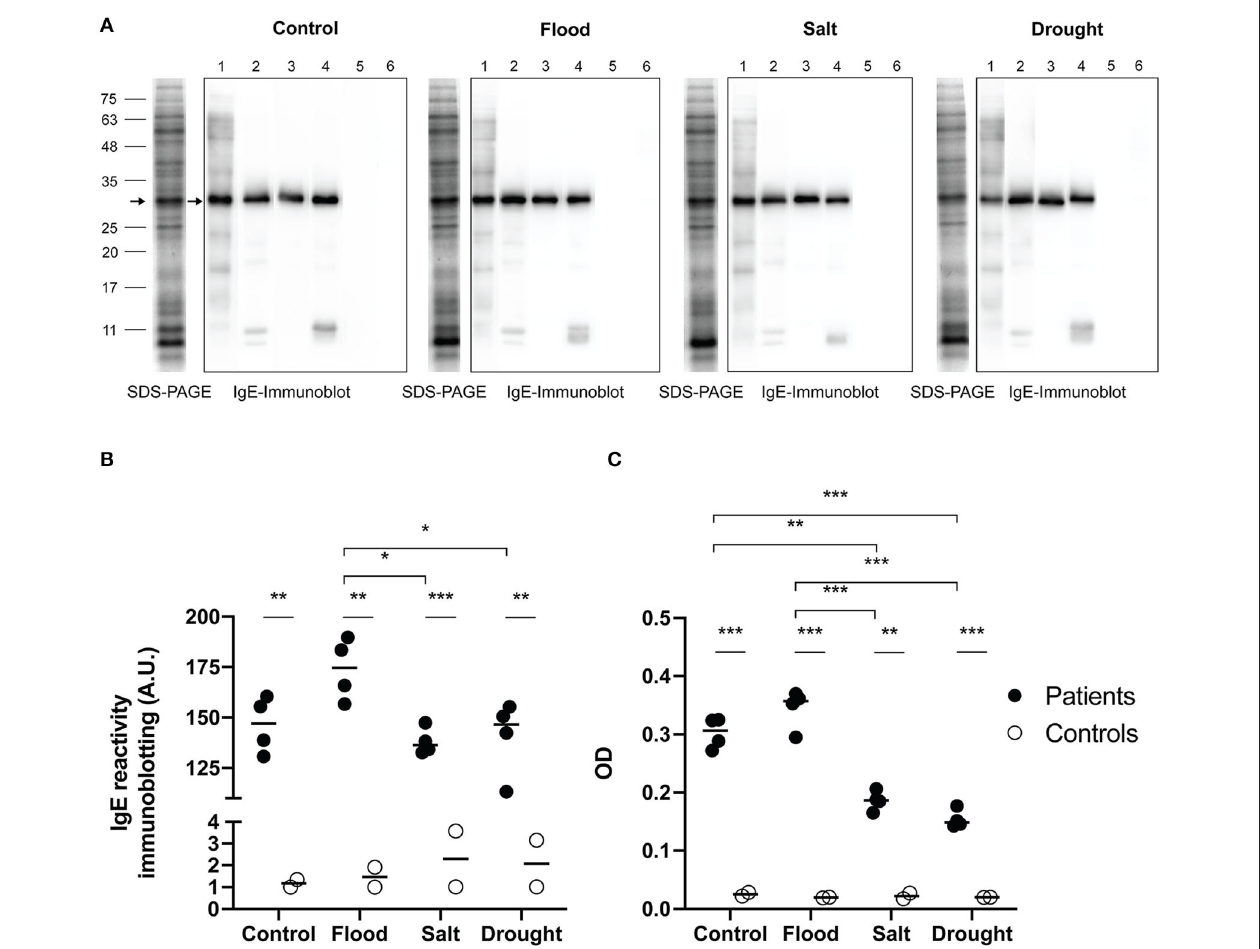
FIGURE 4 | IgE reactivity to rice pollen protein extracts. SDS-PAGE and IgE immunoblots (A) of rice pollen protein extracts under stress conditions from four representative patient samples for grass pollen (no. 1–4) and two representative control samples (no. 5–6), were shown. Arrows on IgE immunoblots indicate major IgE reactive bands. An arrow on each SDS-PAGE indicated the corresponding protein band. The interleaved scatter plot showed intensity of IgE immunoblot (B) and ELISA OD (C) indicated IgE reactivity between grass-allergic patients ( n = 4) and controls ( n = 2) to each of the experimental rice pollen extracts were illustrated. Comparing IgE level between grass-allergic patients and controls to each of the experimental rice pollen extracts was tested by Mann-Whitney U -test. Comparing IgE level between control, flood, salt, and drought rice pollen extracts was performed by one-way ANOVA with Tukey’s multiple-comparison test for parametric data or Kruskal-Wallis H -test with Dunn’s multiple-comparison test for nonparametric data. A statistically significant difference was indicated with the following asterisks: *( p < 0.05), **( p < 0.001), and ***( p < 0.0001).